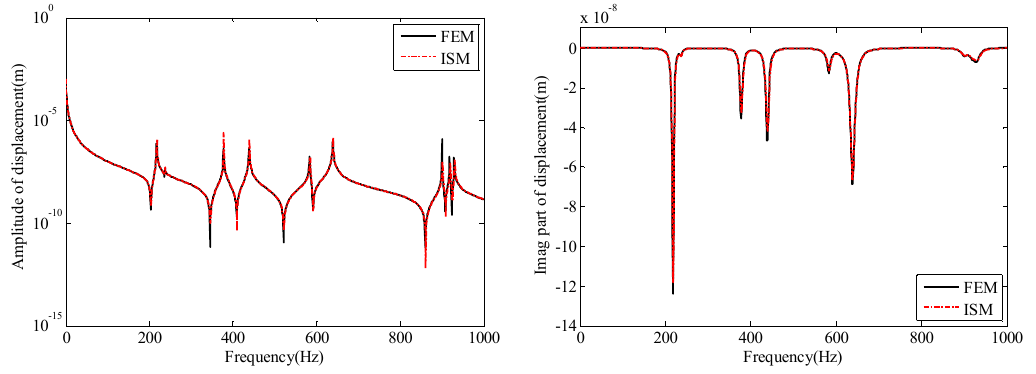
Figure 3. Displacement comparison of ISM and FEM of point P1 on the Z direction. The amplitude and imaginary part of displacement of point P1 in Y direction in 1~1000 Hz domain is compared with FEM in Figure 4. We can see that both the amplitude and imaginary parts of this displacement are in good agreement too.